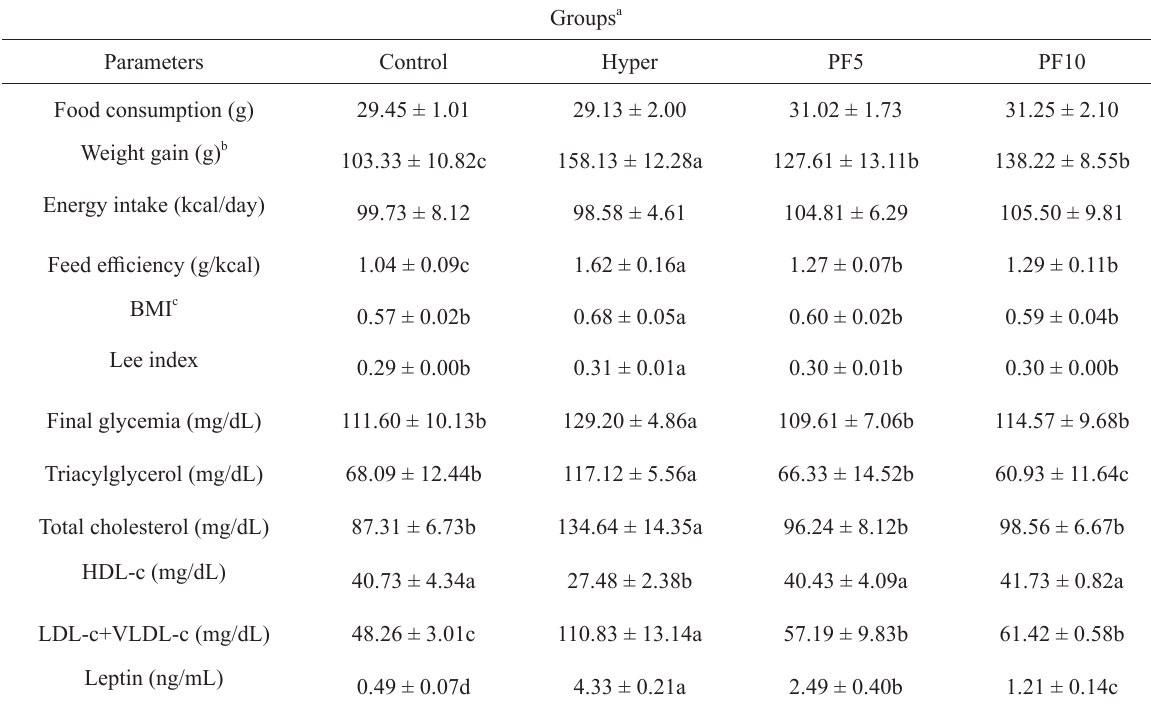
General parameters and serum profile of animals in the groups: Control (standard diet AIN-93G), Hyper (hypercholesterolemic diet), PF5 (hypercholesterolemic diet + 5% peel flour) and PF10 (hypercholesterolemic diet + 10% peel flour) for